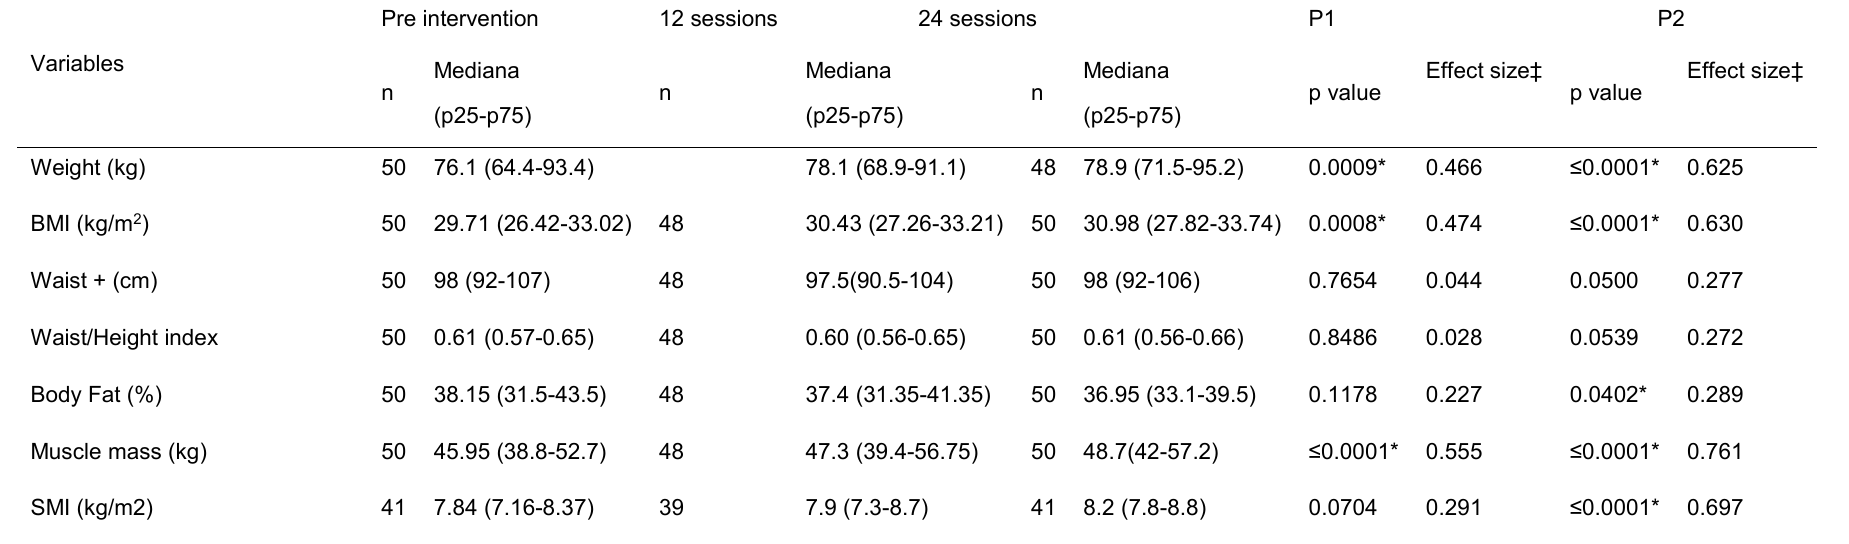
Modifications on Anthropometrics and Body Composition at 12 and 24 Sessions